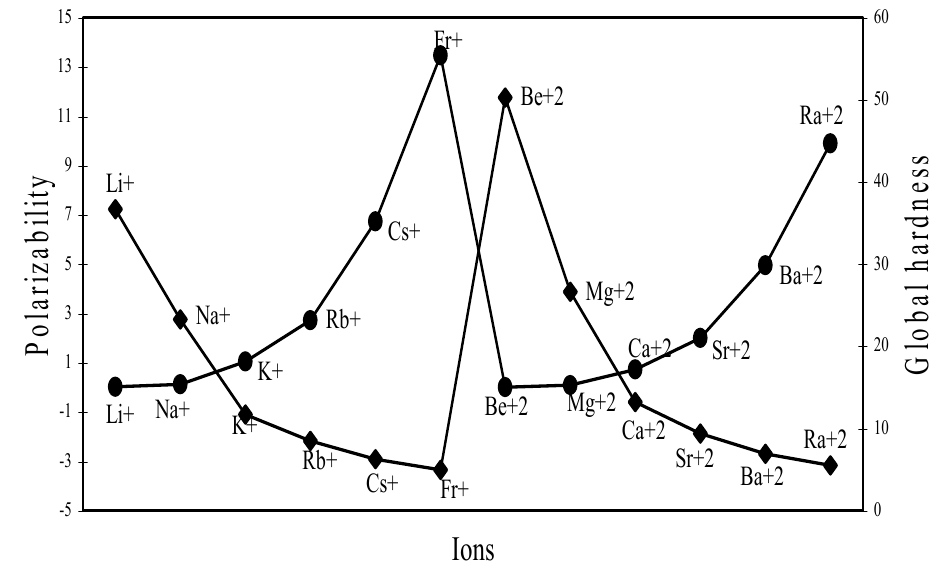
Figure 26. Plot of polarizability and global hardness of ions of Gr-I and Gr-II elements.